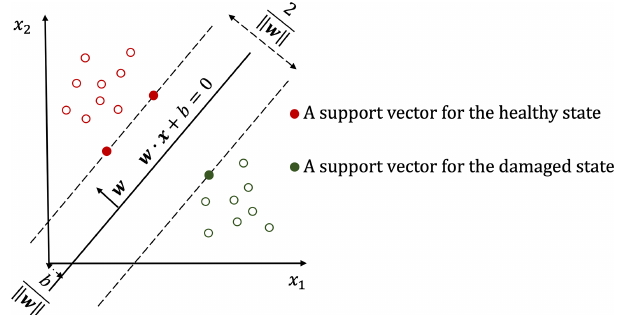
Figure 1. The maximum-margin hyperplane for an SVM used as the optimal